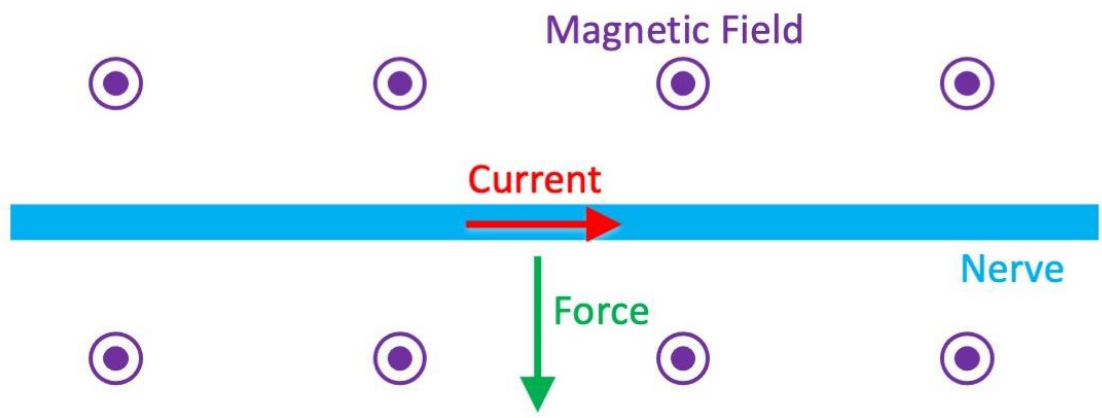
Figure 4. The Lorentz force acting on a nerve. The magnetic field (purple) is uniform and directed out of the paper. An action potential propagates from left to right along a nerve (blue). The action current associated with the upstroke of the action potential (red) experiences a magnetic force (green) according to the “right -hand- rule”; this Lorentz force is perpendicular to both the current and the magnetic field.